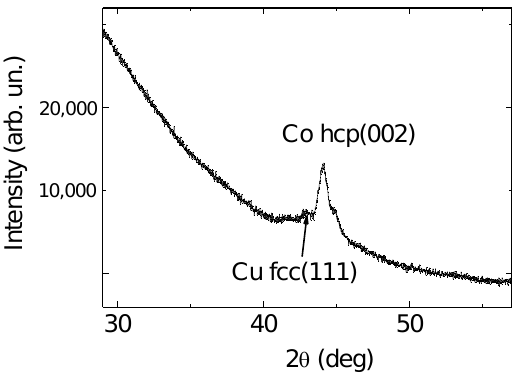
Figure 1. X-ray diffraction spectrum for Gd-Co(35 nm)/Co(7 nm)/Cu(4 nm)/Co(7 nm) film.